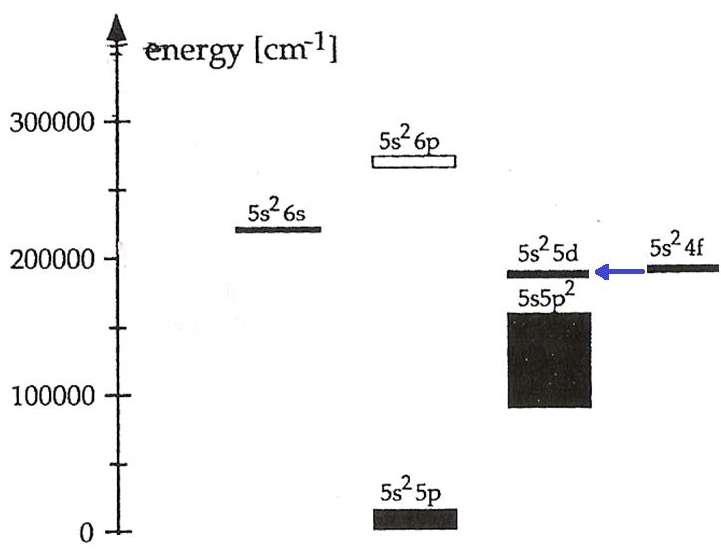
Figure 3. New 5s 2 4f 2 F 7/2 –5s 2 5d 2 D 5/2 laser line at 33224.0 Å . Reproduced by permission of IOP